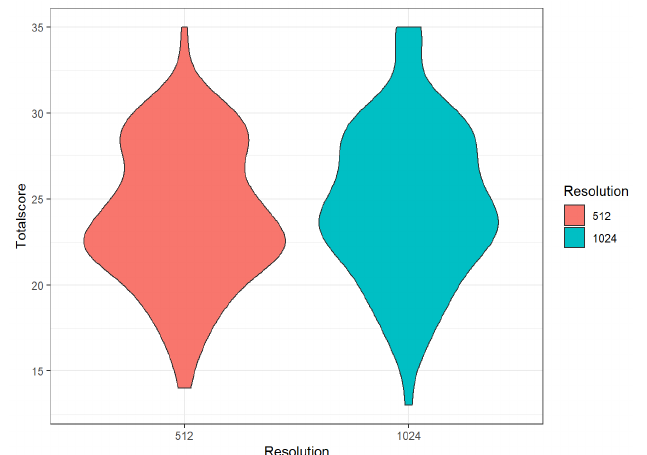
Figure 2. Violin plot: Total score per Matrix size (resolution) 512 and 1024 (mean for all 4 raters).